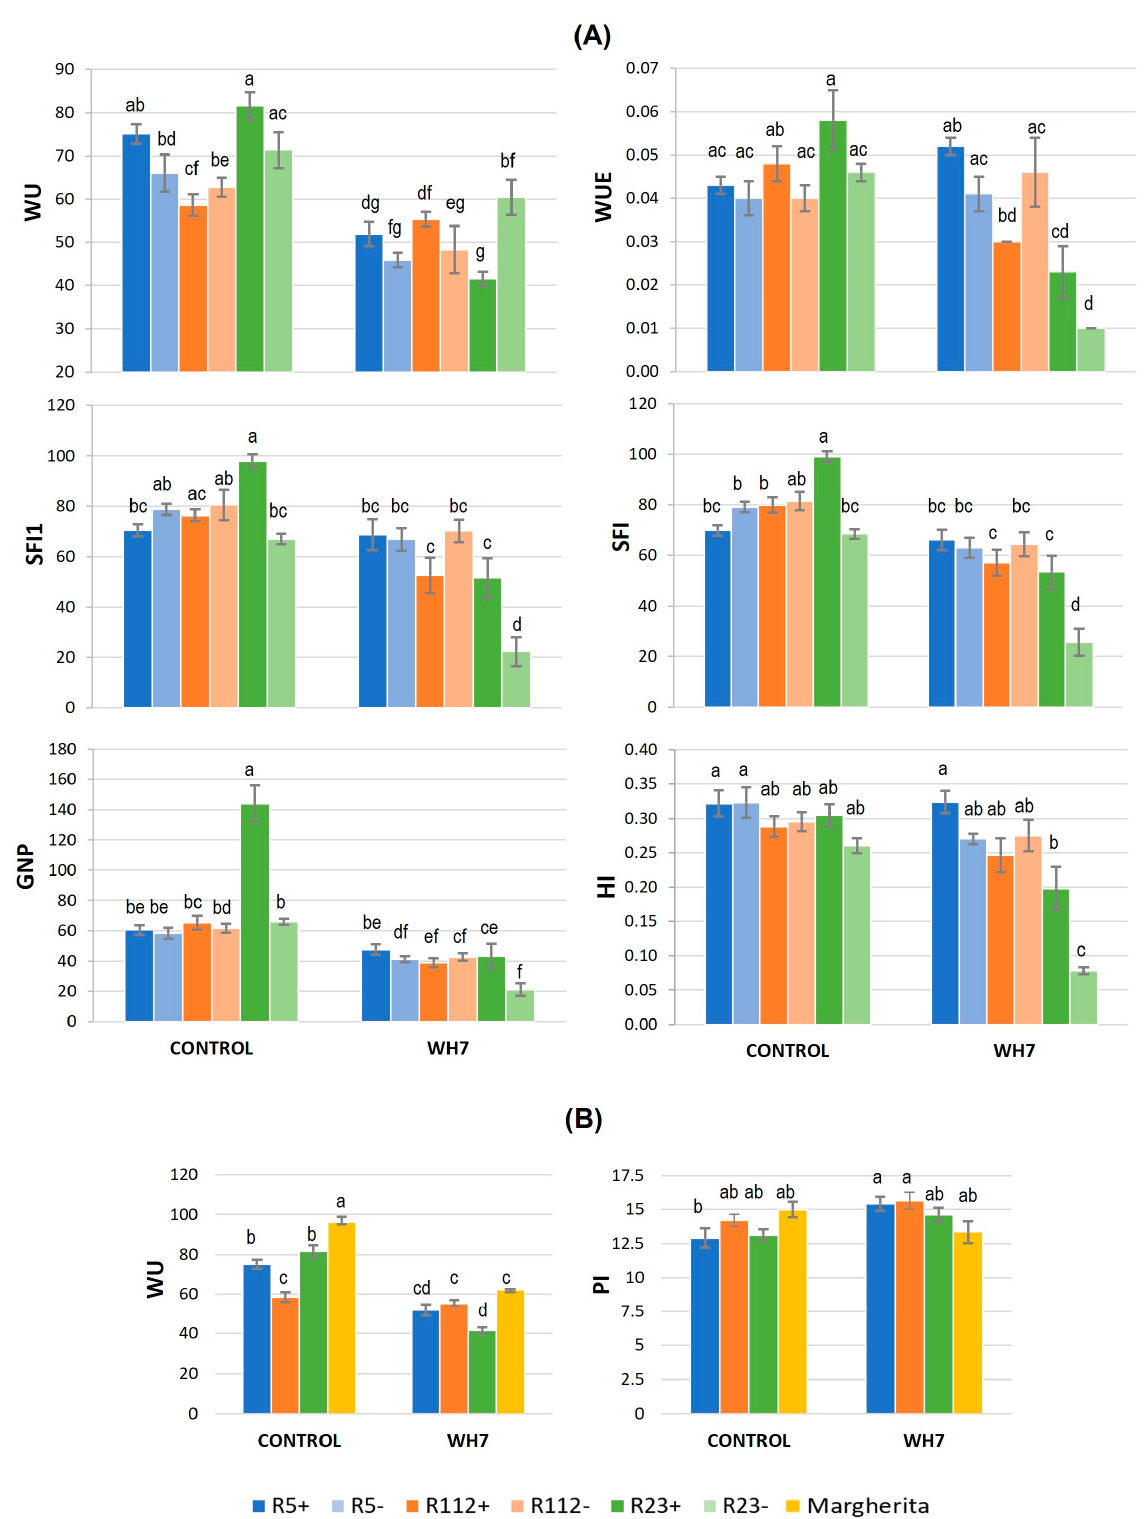
Figure 6. Significant genotype × treatment effects on physiological and yield-related parameters under combined water-deficit and 7-day heat stress (WH7): ( A ) comparison between alien segment carrier (+) and non-carrier ( − ) NIRLs, and ( B ) comparison between NIRLs+ and cv. Margherita. The error bars represent standard errors of the means, while the letters above the histograms correspond to the ranking of Tukey HSD test at p < 0.05 significance level. For trait acronyms, see the Materials and Methods section.